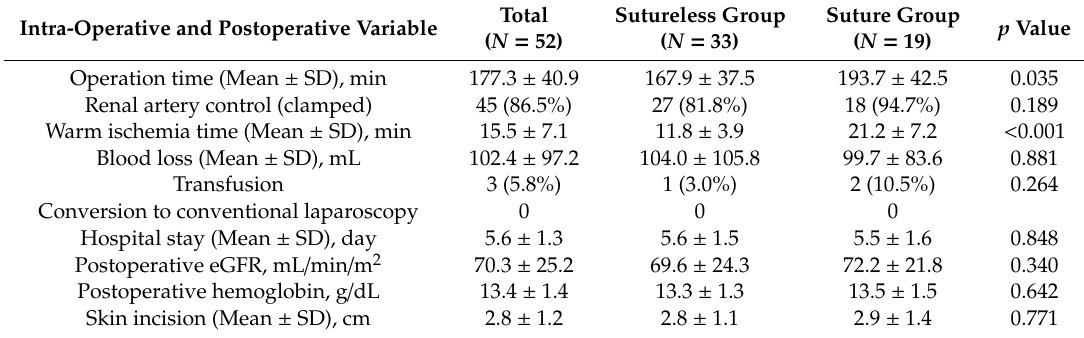
Table 2. Intraoperative and postoperative data on patients who underwent surgery.